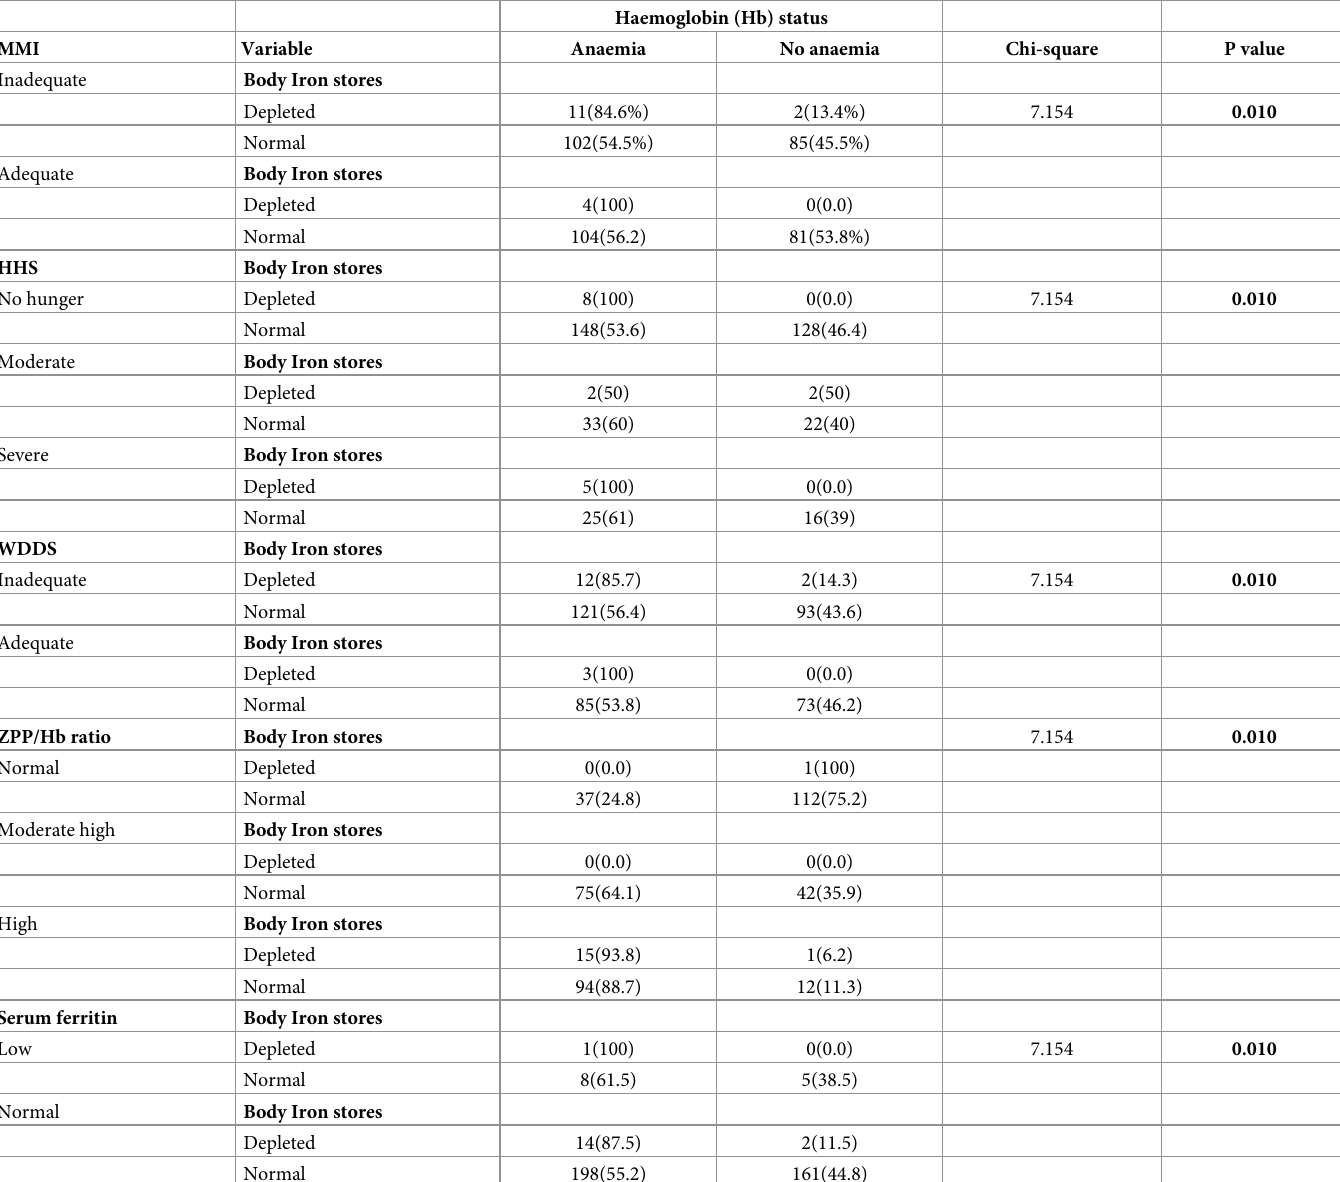
Table 3. Interplay between MMI, HHS, WDDS, ZPP/Hb ratio, serum ferritin, body iron stores, and Hb